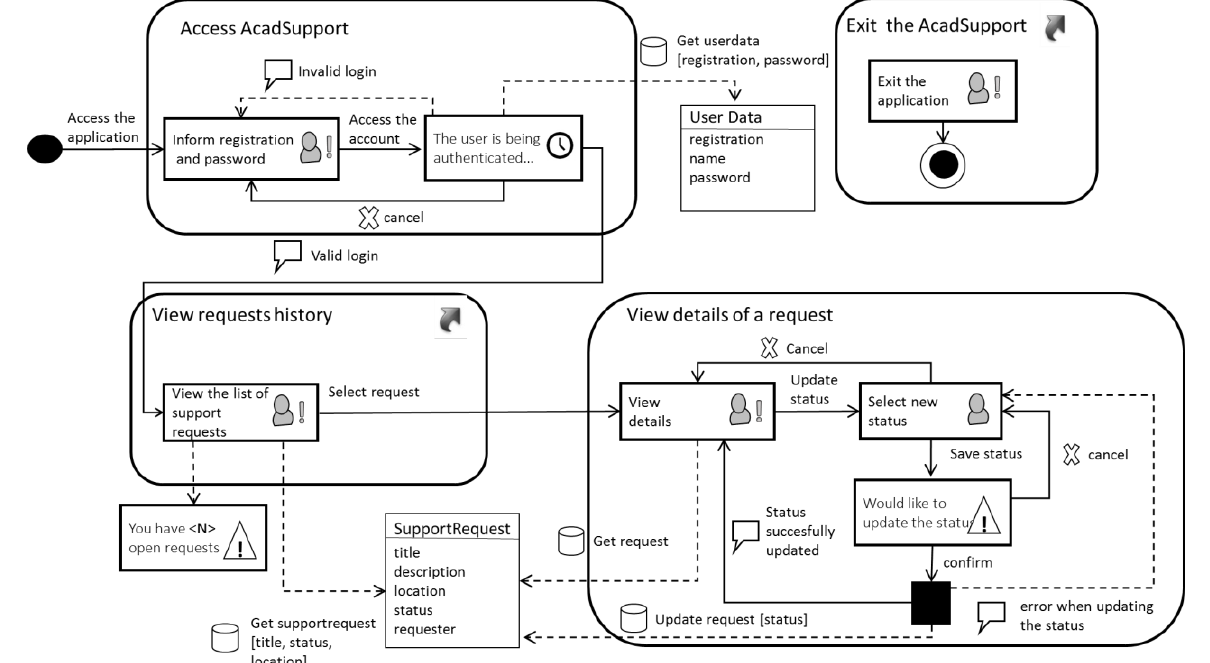
Fig 8. Example of a USINN diagram - after the refinement of the